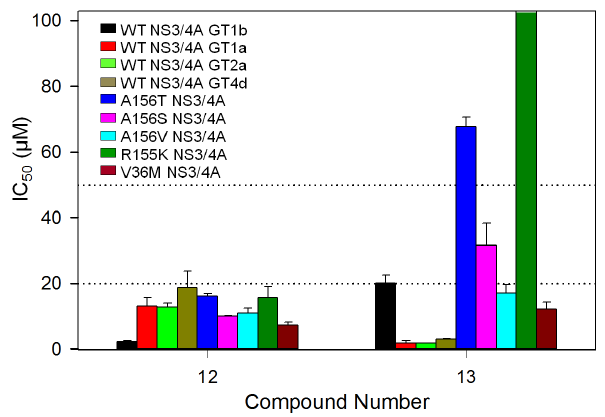
Figure 4. IC 50 value comparisons of two confirmed hit compounds. Bar graphs are shown with IC 50 values of two identified compounds against NS3/4As from four HCV genotypes, genotypes 1a (GT1a), 1b (GT1b), 2a (GT2a), and 4d (GT4d), and five mutants from genotype 1b. IC 50 determination was done in triplicate with a total of 32 positive and 32 negative controls in a plate. IC 50 values were calculated by fitting the data to the three parameter Hill equation with OriginPro 8.5 (See Methods). Bars that reached the top represent IC 50 values of over 100 m M (no inhibitory effect).